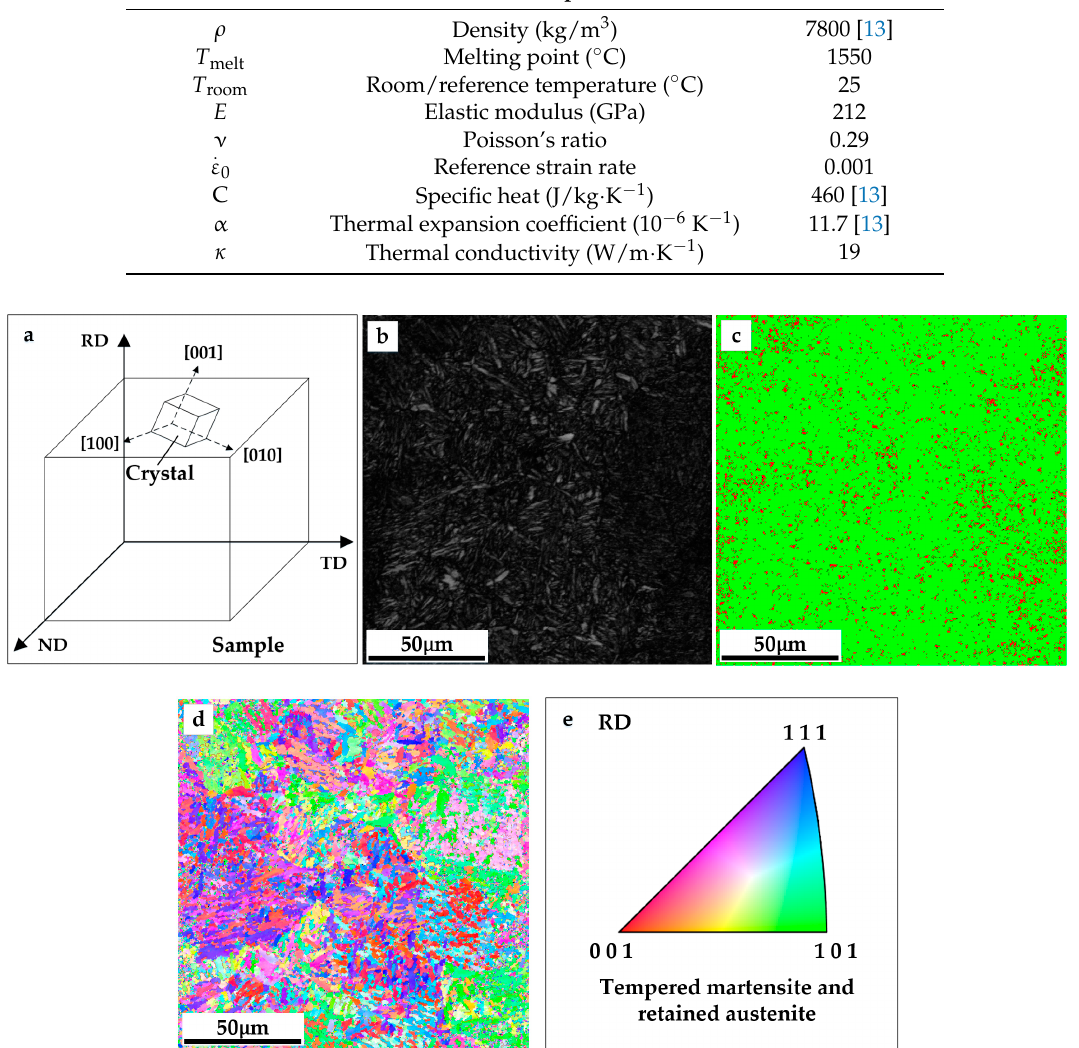
Figure 1. ( a ) Sample directions: RD represents rolling-direction, TD represents transverse-direction and ND represents normal-direction; ( b ) Scanning electron microscope (SEM) metallographic graph; ( c ) distribution of martensite and austenite grains, green area represents tempered martensite and red area represents retained austenite; ( d ) RD inverse pole figure; ( e ) color code map of the RD inverse pole figure. Table 1. Chemical composition of 45CrNiMoVA (wt. %).